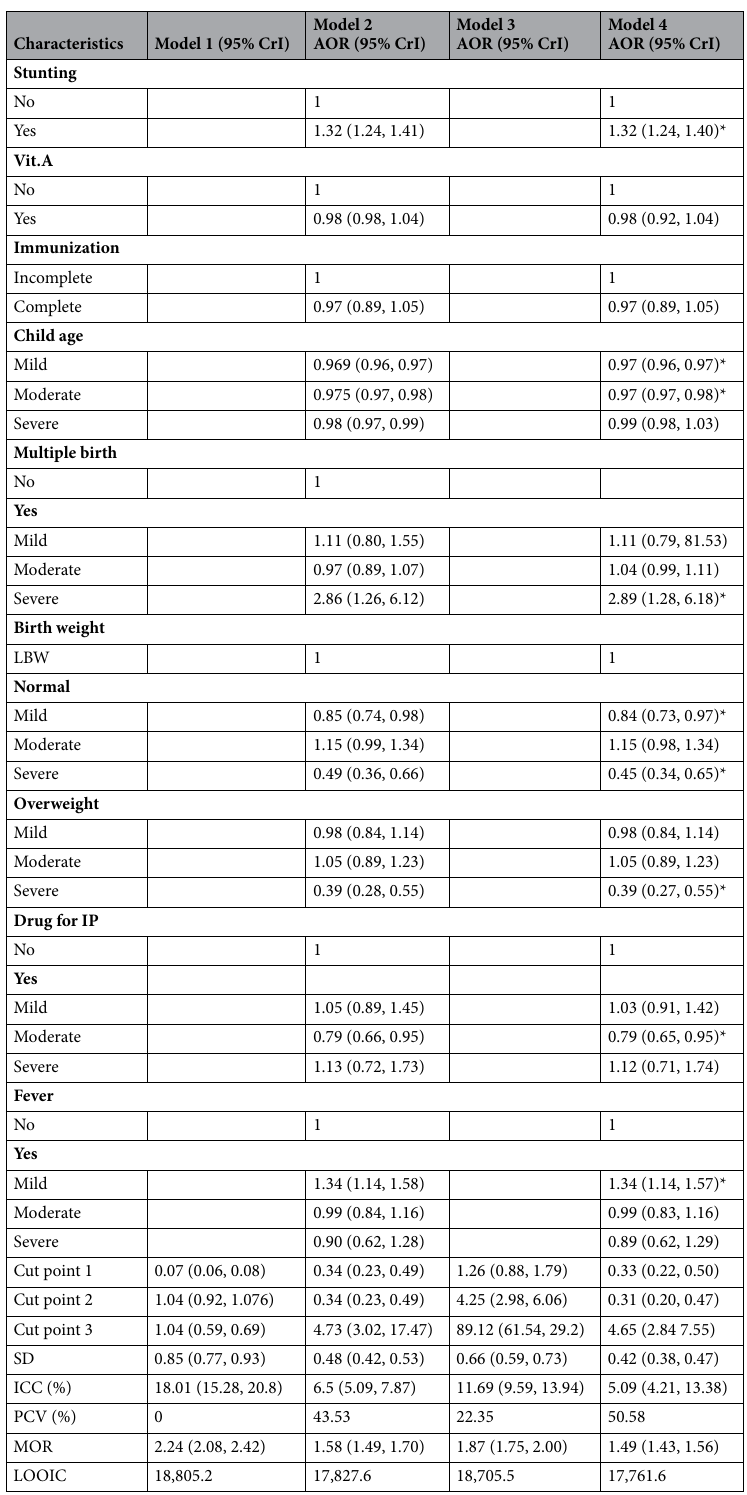
Table 2. Multivariable ordinal logistic regression based on hierarchical Bayesian statistical approach result of factors associated with anemia of children aged from 6 to 59 months in Ethiopia, EDHS 2016